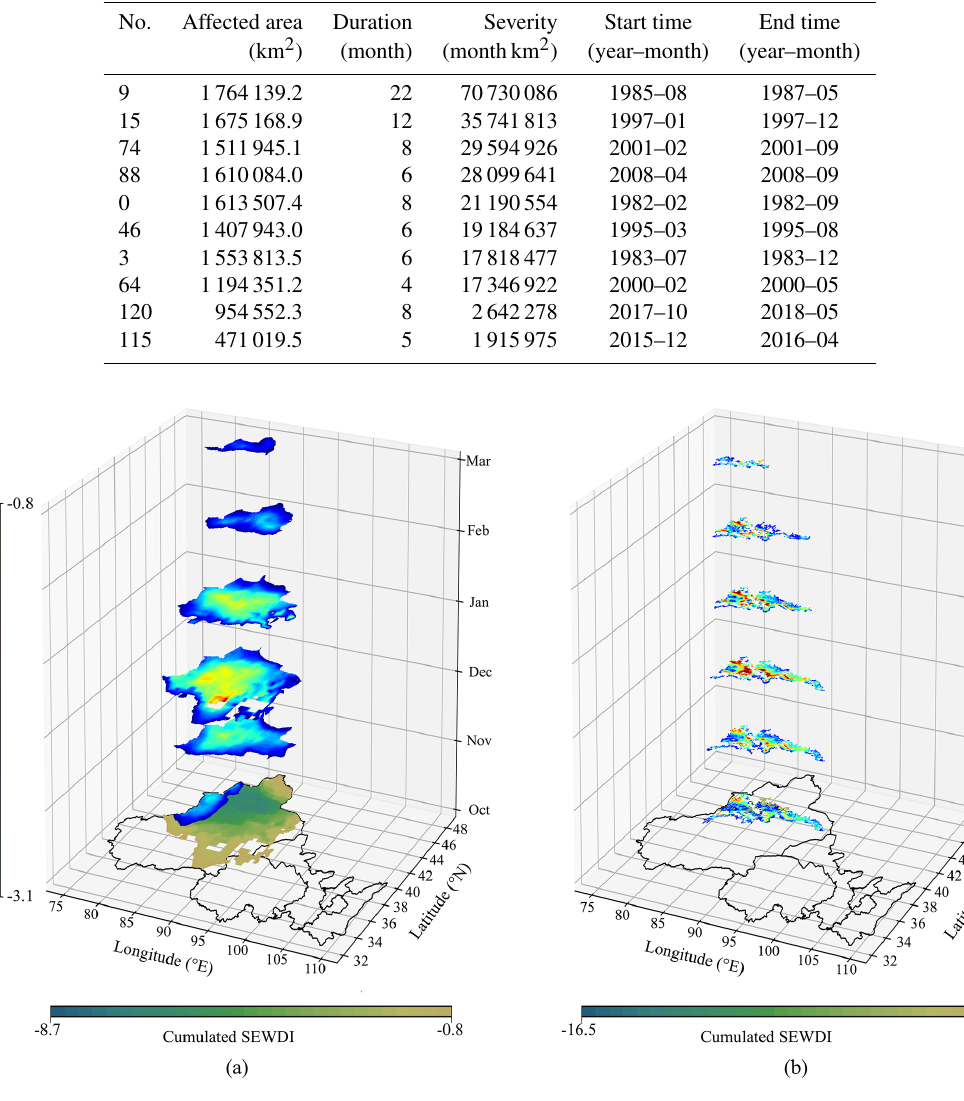
Figure 6. Spatiotemporal continuums of (a) meteorological drought event No. 87 and (b) ecological drought event No.